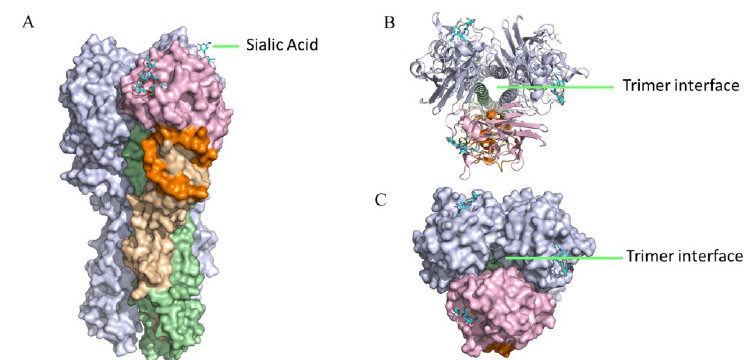
Figure 2. Antibody-dependent cellular cytotoxicity (ADCC)-epitopes in HA. Antibodies targeting HA stalk, as well as HA head including esterase domain and trimer interface, can induce potent ADCC in vitro and elicit broad-spectrum protection in vivo . The HA structure is generated using PyMOL. A / California 04 / 2009 HA (PDB code: 3UBE) is used as a representative HA structure to show the location of ADCC-epitopes. Influenza HA is a trimer with each monomer comprised of HA1(wheat), vestigial esterase domain (orange) and receptor binding domain (pink), and HA2 (palegreen). The remaining two monomers are shown in light blue. Sialic acid is colored cyan. Side view of the HA trimer surface is shown in ( A ), while the top view of the HA trimer interface is shown in the cartoon ( B ) and surface ( C ) modes. Besides, there are ADCC-Abs targeting HA head with unknown epitopes [100] .